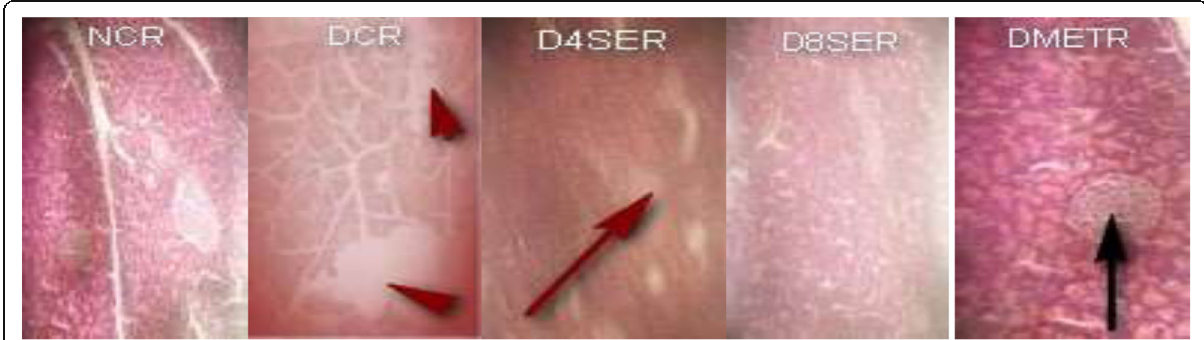
Fig. 7 Effects of SE extract on the histological architecture of the pancreas. NCR: Normal control rat showing normal pancreatic architecture with intact exocrine tissue and islet cells surrounded by delicate capsule. DCR: Diabetic control rat with exocrine tissue showing massive degeneration and endocrine tissue exhibiting hyperplasia reminiscent of hypoglycaemia. D4SER: Diabetic rat treated with 400 mg of SE per kg BW (p.o) showing mild atrophy of the pancreatic cell compared to DCR. D8SER: Diabetic rat treated with 800 mg of SE per kg BW (p.o) showing pancreatic cells regeneration to near normal. DMETR: Diabetic rats treated with 12 mg of Metformin per kg BW (p.o) showing pancreatic histology similar to that of control animal but dented with mild pancreatic cells congestion or